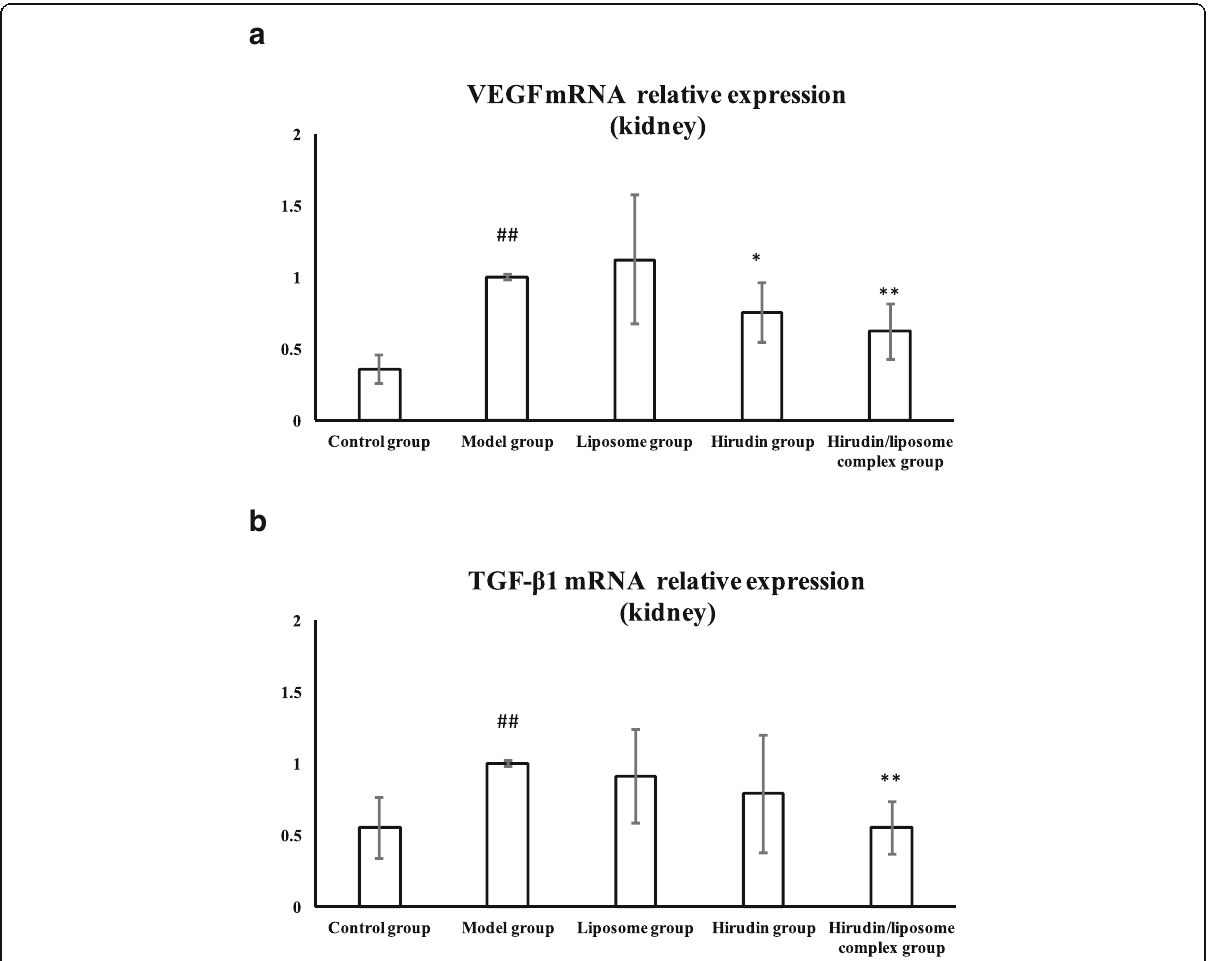
Fig. 8 Gene expression of VEGF ( a ) and TGF- β 1 ( b ) in the kidneys was down-regulated in the Hirudin/liposome complex group compared with the Model group. Control group ( n = 10), Model group ( n = 7), Liposome group ( n = 7), Hirudin group ( n = 8), Hirudin/liposome complex group ( n = 7). ##: P <0.01 compared with Control group; *: P <0.05 compared with Model